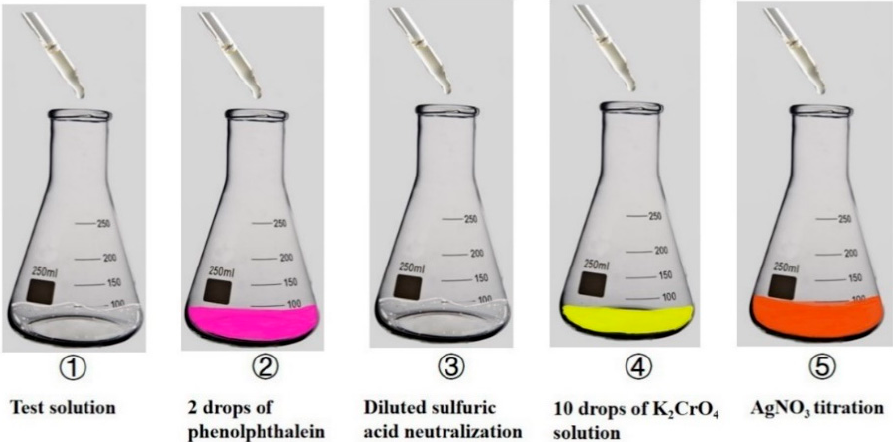
Figure 4. Schematic diagram of the procedure for water-soluble chloride content test.